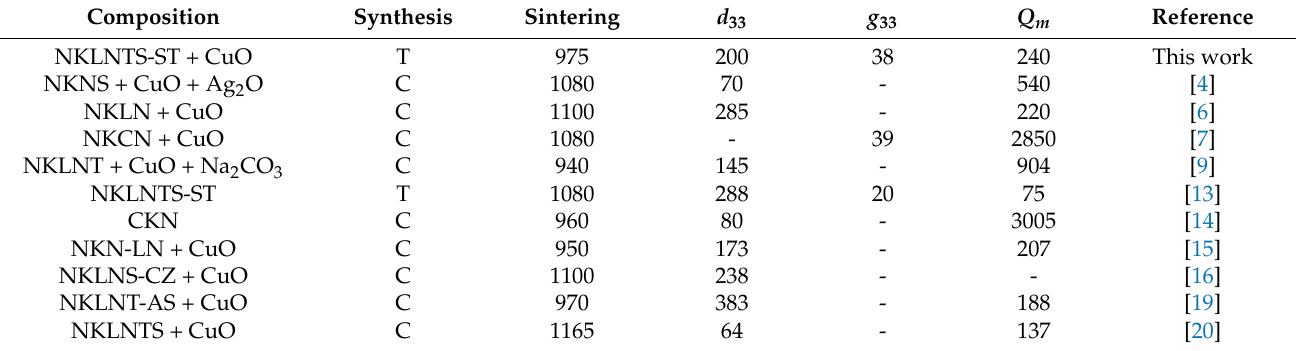
Figure 7. Piezoelectric parameters ( a ) k p , Q m and ( b ) d 33 , g 33 of NKLNTS-ST- x CuO ceramics. Table 3. Comparison of this work with the previous reports.